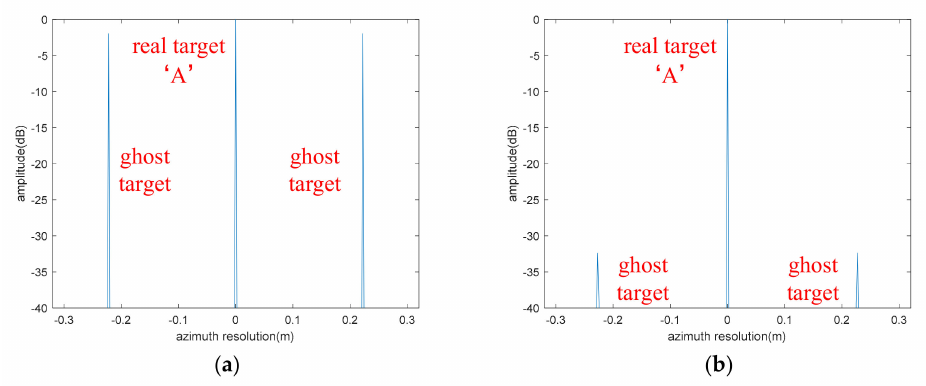
Figure 13. Azimuth profile of targets in the red dashed boxes in Figure 12. ( a ) Without compensation and ( b ) with